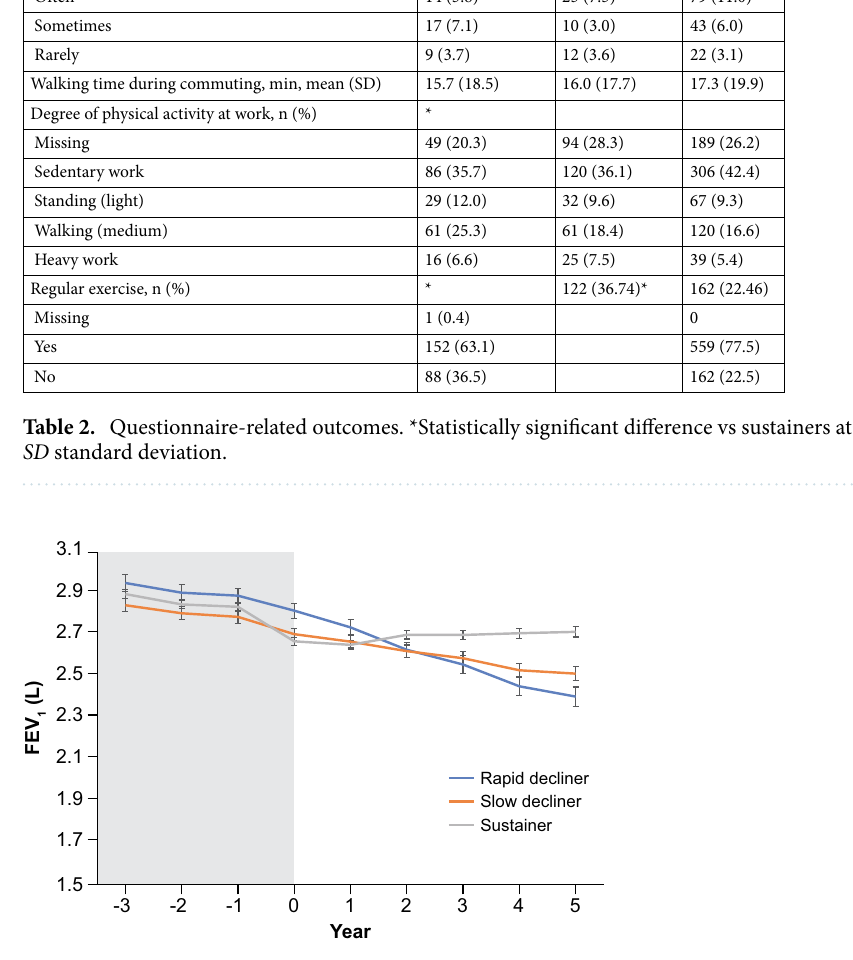
Figure 3. Time profile of lung function across the diagnosis of COPD. FEV 1 forced expiratory volume in 1 s, L